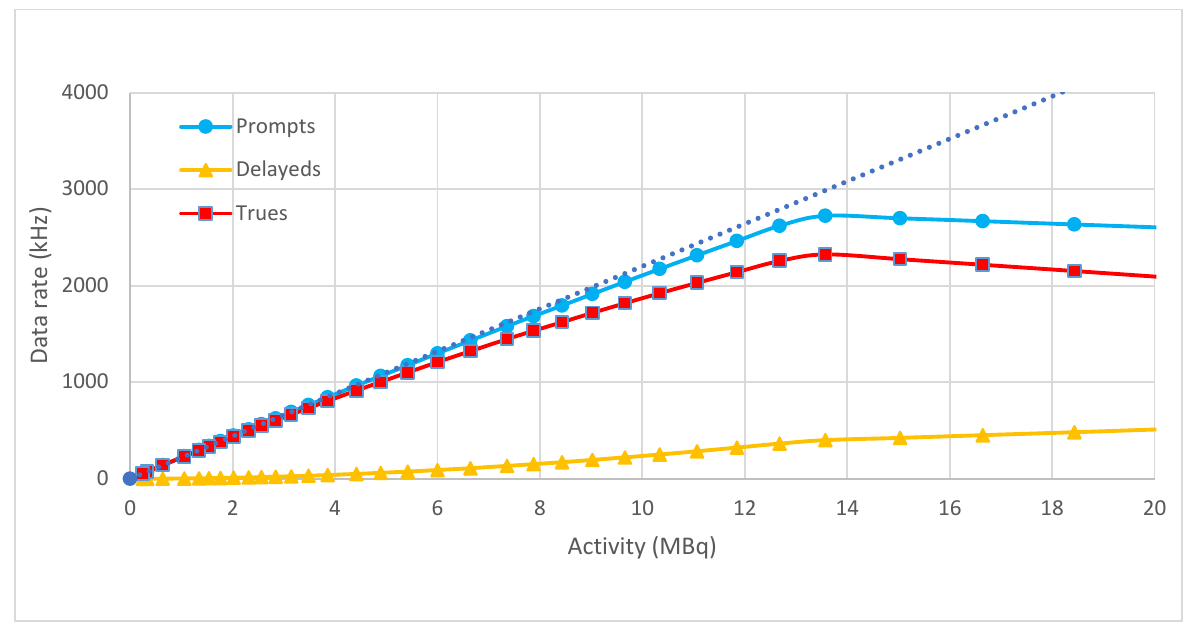
Figure 6. Data rates measured from SuperPEPT for a central 11 C source of varying activity. The upper set of points shows the total coincidence rate, the lower set the delayed coincidence rate, and the middle set the rate of true coincidences given by the difference prompt minus delayed. The dotted line corresponds to a sensitivity of 22%.